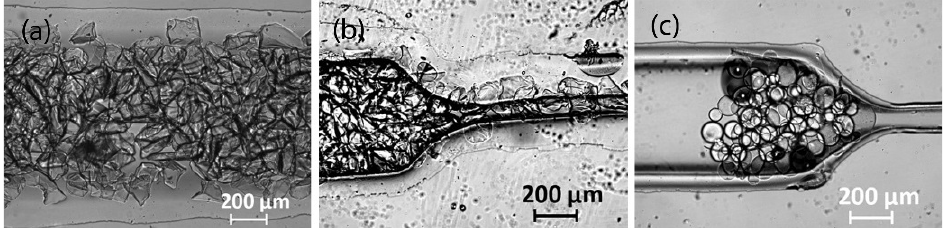
Figure 20. Microfluidic chip replica fabricated through milling on ABS and polished in acetone vapor. ( a ) Channel filled with non-spherical particles. ( b ) Narrow sieve retaining non-spherical particles. ( c ) Narrow sieve retaining spherical particles.